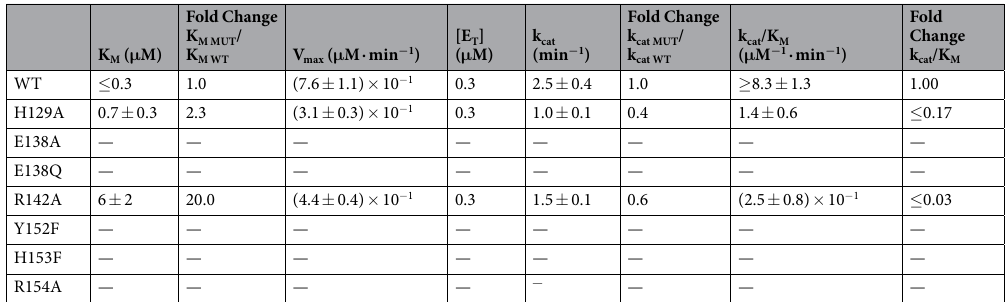
Table 1. Michaelis-Menten analyses of methylation of Δ rlmH -70S ribosomes by RlmH. Fitted Michaelis- Menten curves are shown in Fig. 2. Values for catalytically inactive mutants E138A, E138Q, H153F and R154A are not reported. The table reports mean ± fitting error for two